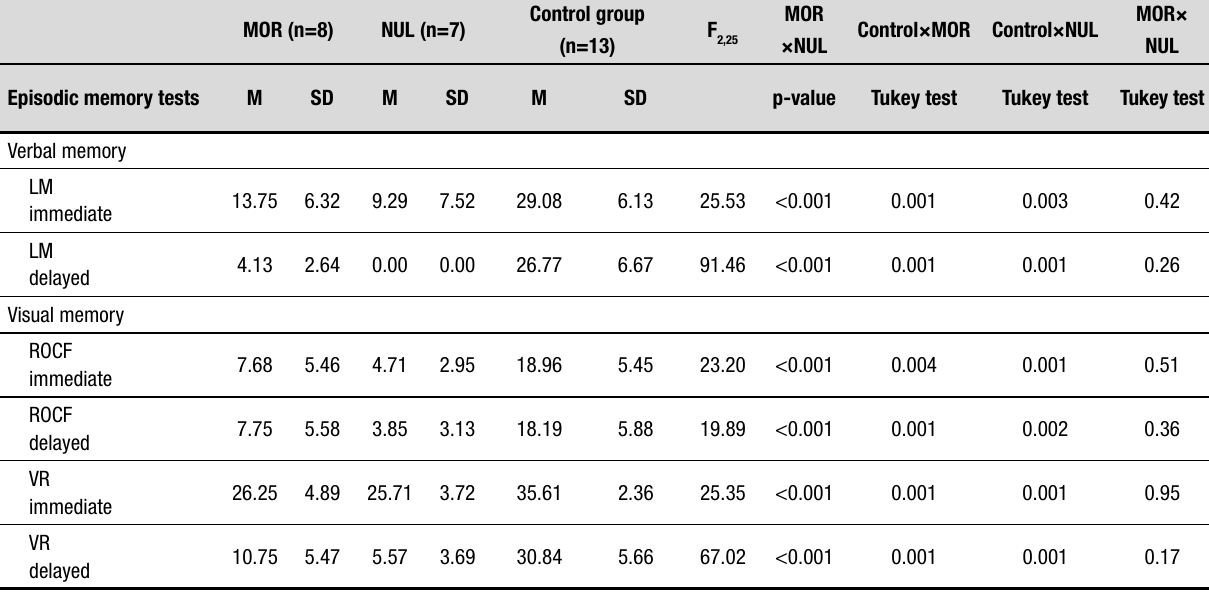
Table 3. Performance in episodic memory task of amnesic subgroup (MOR and NUL) and control group. MOR (n=8)